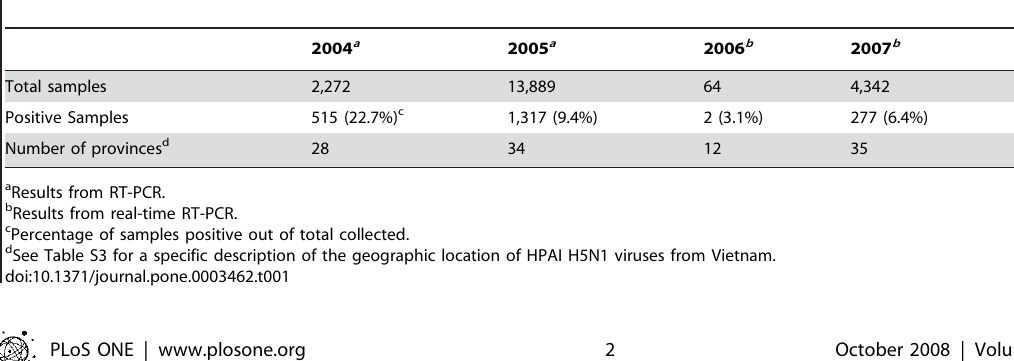
Table 1. Surveillance of HPAI H5N1 in birds in Vietnam from 2004 to